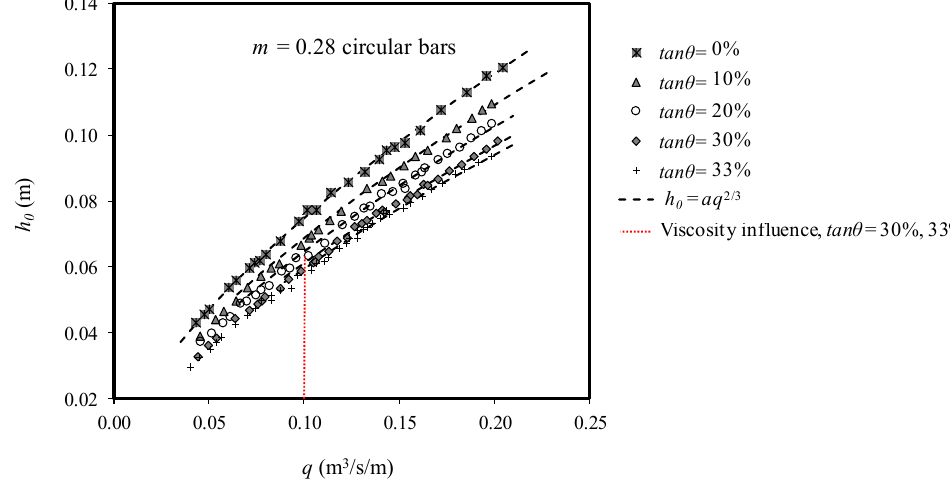
Figure 7. Flow depth at the beginning of the rack h 0 as a function of the incoming flow q . Circular bars with void ratio m = 0.28.